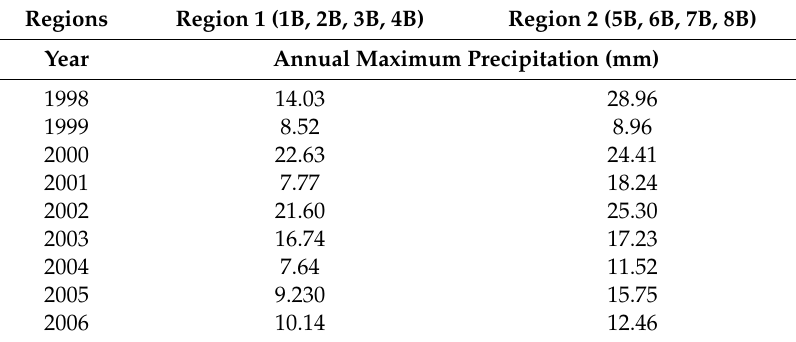
Figure 6. ( a ) Separating the watershed into two regions and ( b ) return period lognormal for Region 1 and Region 2. Table 3. Annual maximum precipitation from 1998 to 2017 based on Tropical Rainfall Measuring Mission (TRMM) Satellite